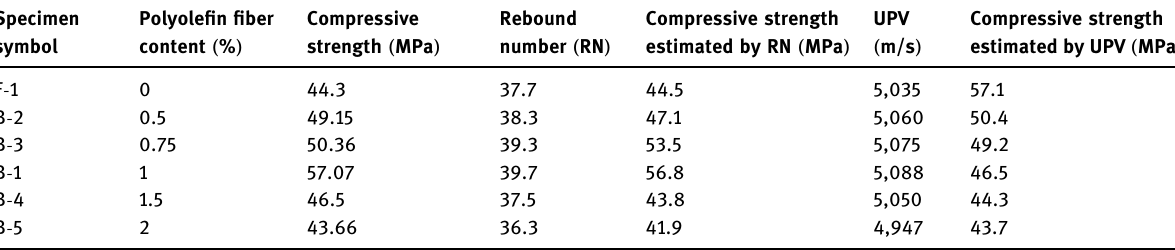
Table 12: Compressive strength and results of nondestructive tests at 28 days Specimen